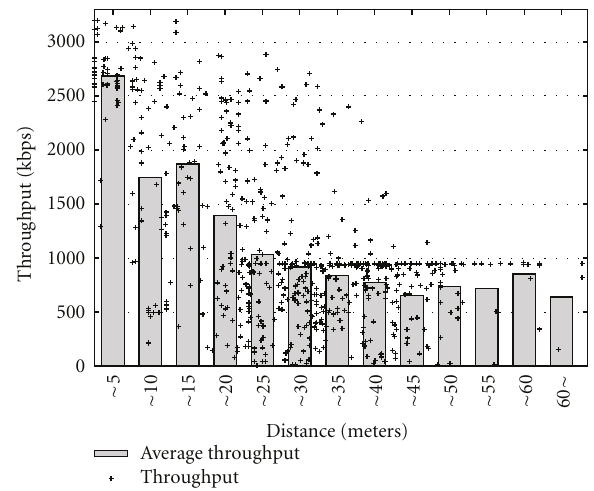
Figure 19: Relation between distance and bandwidth using the MANEMO